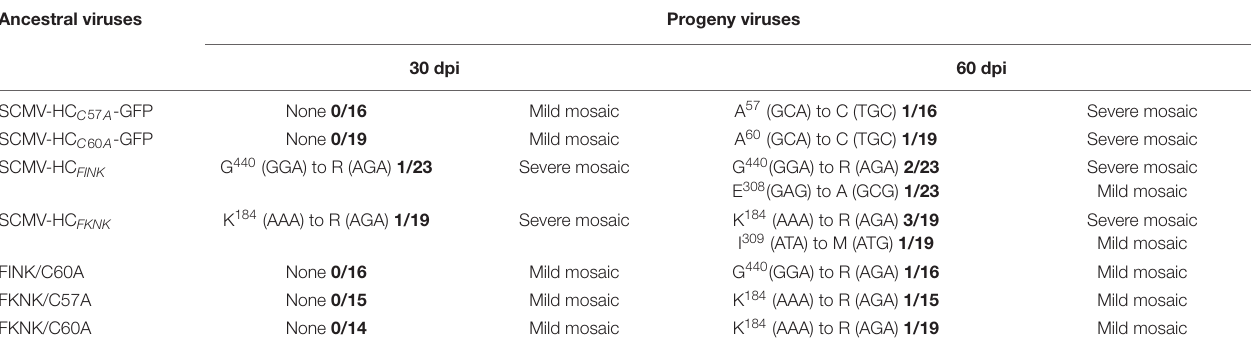
TABLE 1 | Variability of HC-Pro genes and progeny phenotypes of SCMV mutants. Ancestral